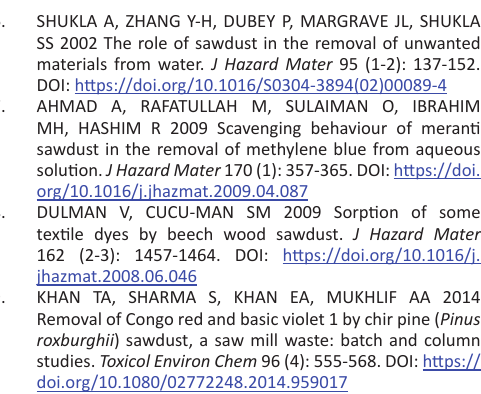
where q (mg·g -1 ) is the amount of dye adsorbed at equilibrium e (mg·dm -3 ) is the equilibrium concentration of dye in the and γ e and n indicate the solution. Freundlich isotherm constants K F ) and whether the adsorption process adsorption capacity (K F is favourable or not (n). The Freundlich constants are given in Table 3. The values of n indicate that the adsorption is linear when n=1, n<1 indicates that adsorption is a chemical process, while n>1 indicates favourable adsorption that is a physical process [38]. The results given in Figure 8B and Table 3 indicate that the adsorption of MB onto poplar sawdust is